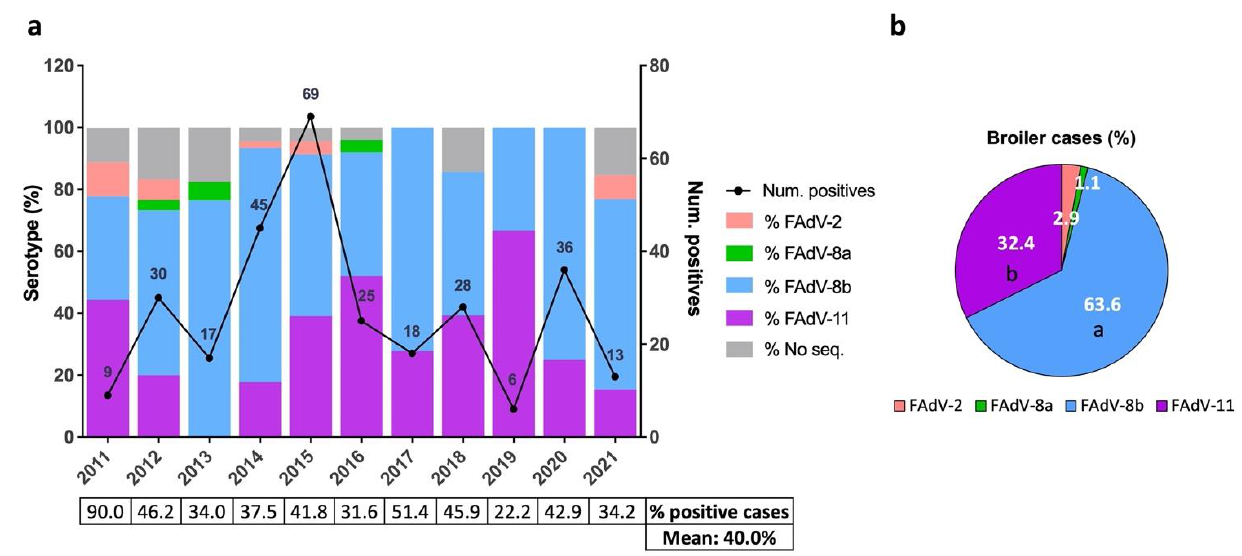
Figure 2. Distribution of IBH cases in broilers between 2011 and 2021 in Spain. ( a ) Number of positive IBH cases in broilers (black line, number of cases per year indicated, (right) y axis) and percentage of FAdV serotypes per year (color-coded bars, (left) y axis). The percentage of positive cases out of the suspected IBH cases submitted per year and overall is shown as a table below. ( b ) Overall percentage of FAdV serotypes in positive IBH cases in broilers. Different letters designate statistical significance in Fisher’s exact test ( p ≤ 0.05).